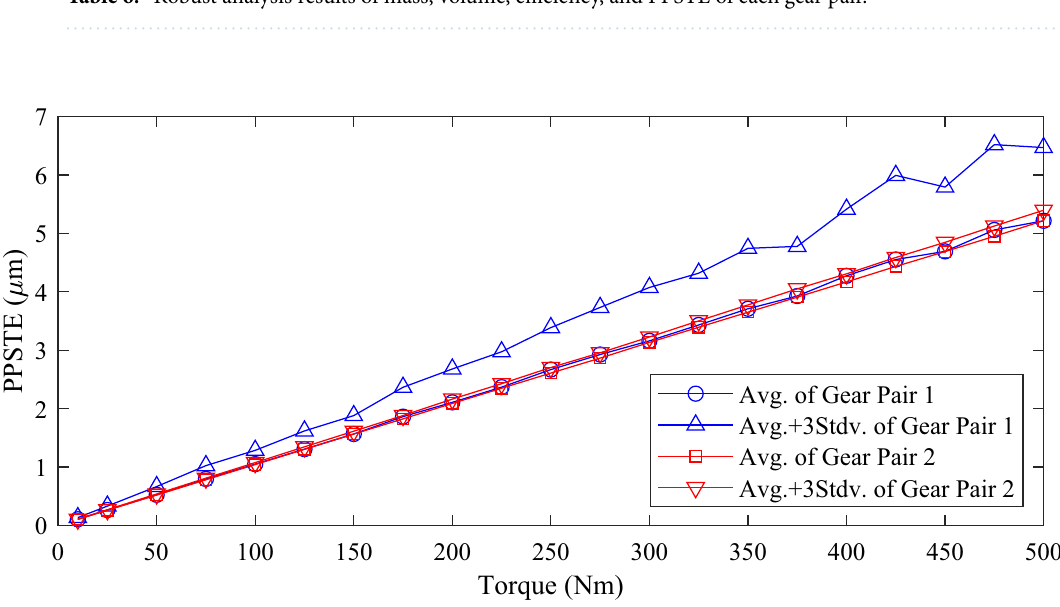
Figure 8. Robustness analysis results (Avg. and Avg. + 3Stdv.) for PPSTE according to